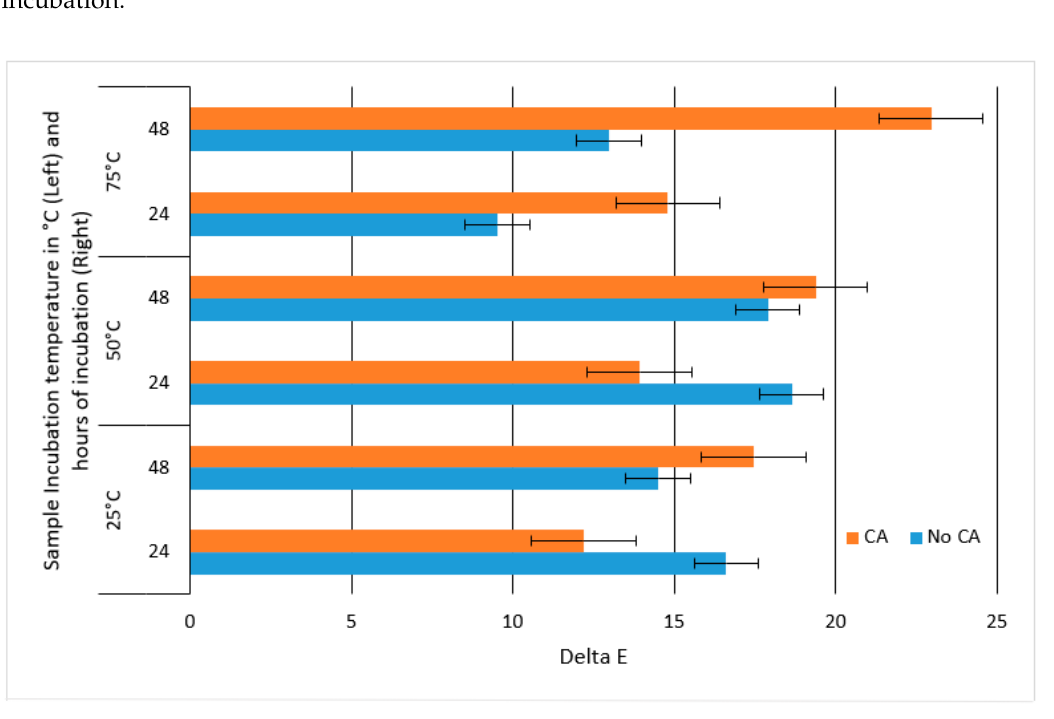
Figure 5. Average Δ E* ab of samples incubated at 25, 50, or 75 °C between samples incubated for zero Figure 5. Average ∆ E* ab of samples incubated at 25, 50, or 75 ◦ C between samples incubated for zero hours and either 24 or 48 h with or without caffeic acid (CA). Error bars represent the standard hours and either 24 or 48 h with or without ca ff eic acid (CA). Error bars represent the standard deviations.